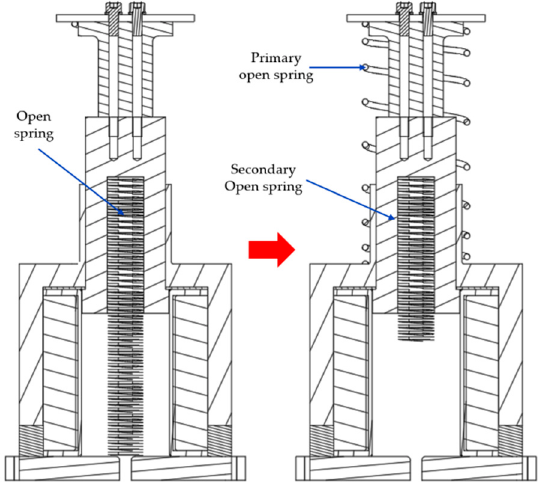
Figure 13. Open spring designs of single spring type ( Left ) and double spring type ( Right ).